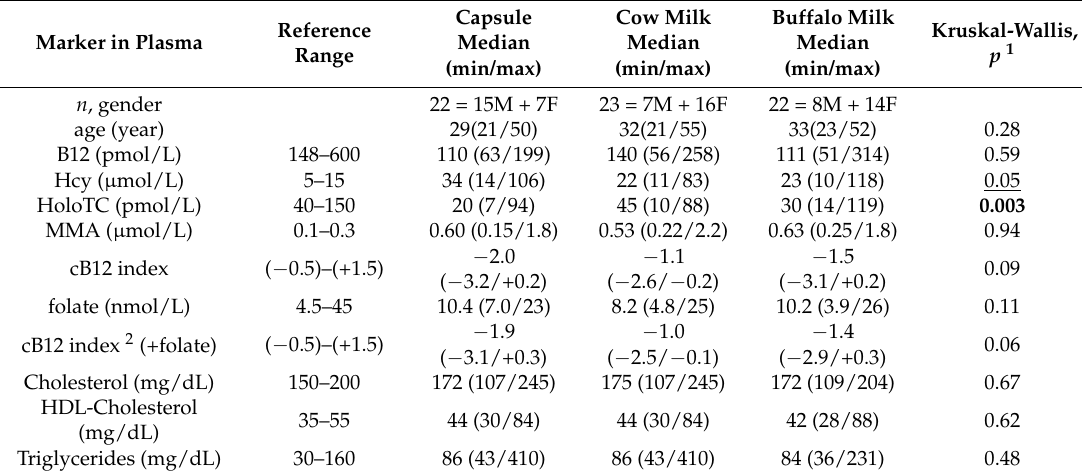
Table 1. Measurements of biomarkers at baseline for individuals destined for intervention with B12 present in capsules, cow milk or buffalo